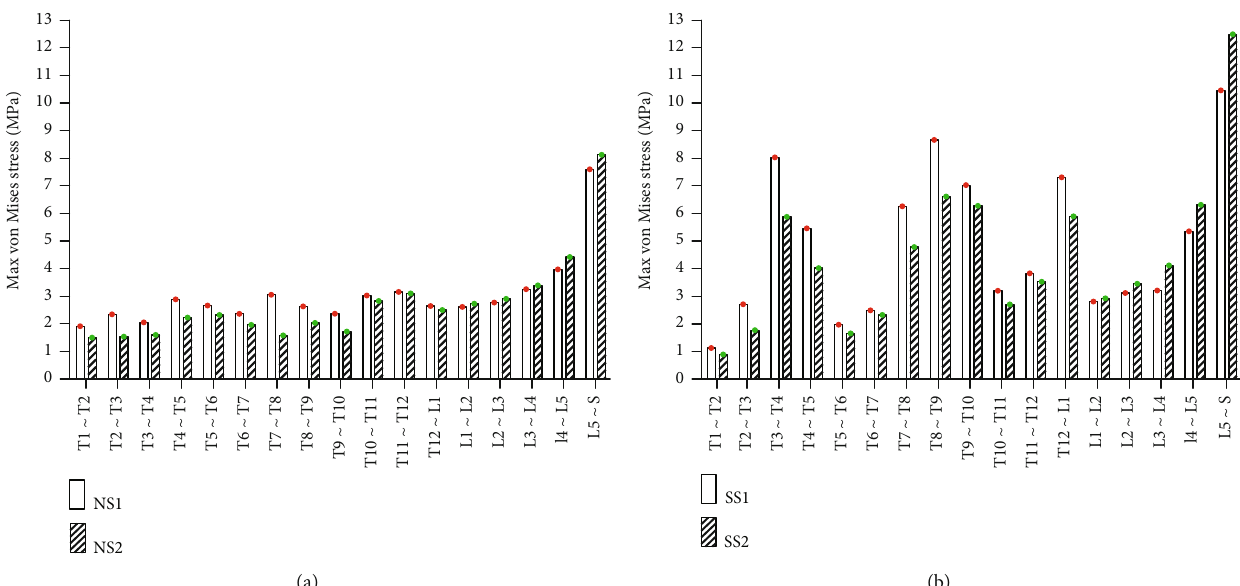
Figure 5: Stress distribution of discs in four spinal models with left curvature: (a) stress distribution of normal spinal intervertebral disc; (b) stress distribution of scoliotic spinal intervertebral disc. NS1, NS2, SS1, and SS2 need to be de fi ned